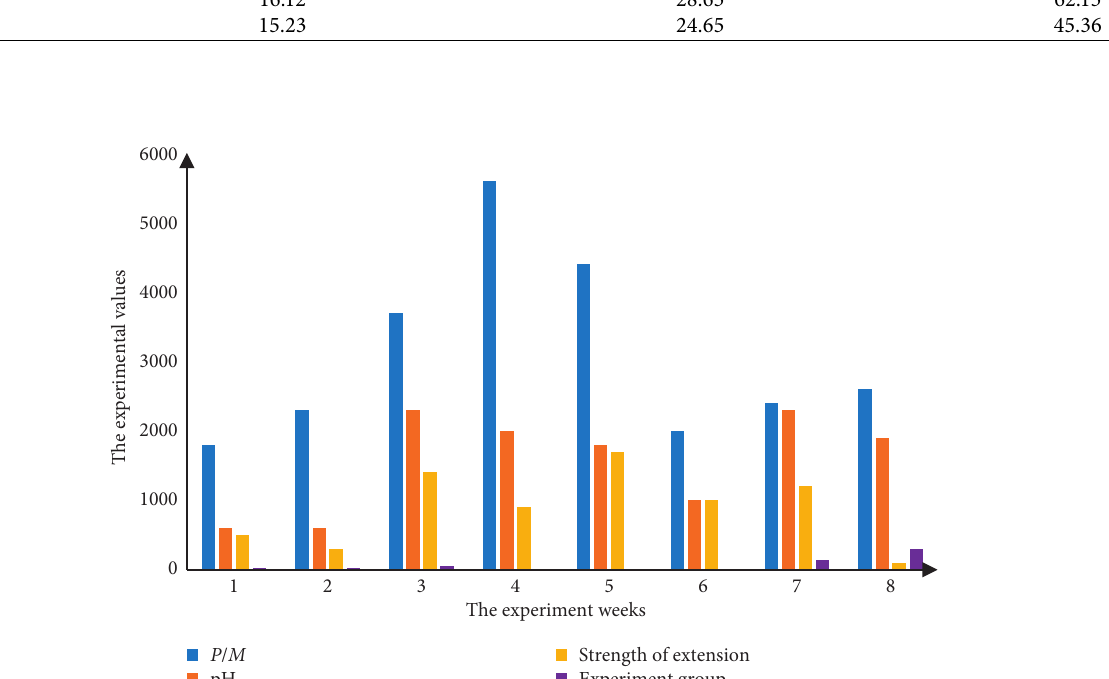
Figure 1: Effect of P / M on compressive strength of fiber-reinforced magnesium phosphate cement-based nanocomposites in bridge structure repair and reinforcement.